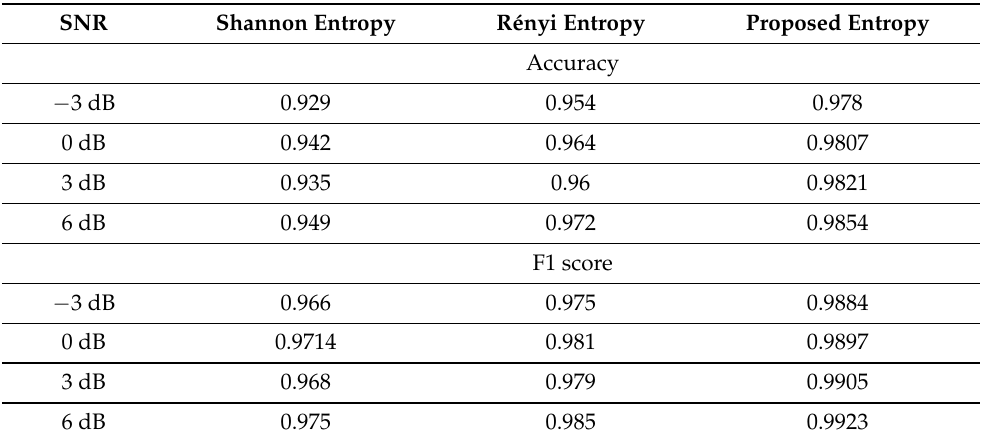
Table 6. Classification results for the first